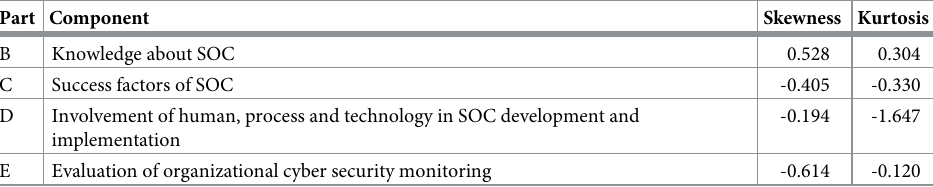
Table 6. Normality analysis test.